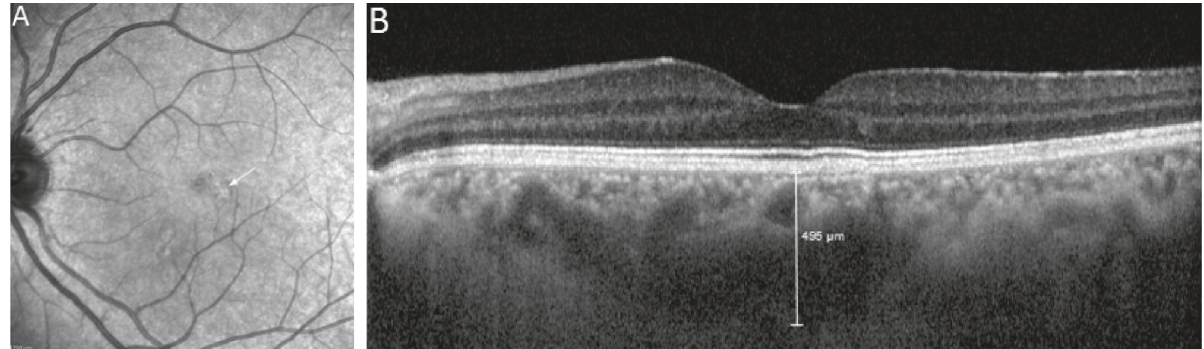
Figure 2: An infrared reflectance image (A) and enhanced depth imaging (EDI) mode of spectral domain optical coherence tomography (SD-OCT) image (B) of a 32-year-old female patient with coeliac disease. Slight hyperreflectivity appears on the infrared reflectance image in the parafoveal region (white arrow). In the SD-OCTimage, pachyveins (enlargement of Haller’s layer) under the retinal pigment epithelium change, and thick choroid (subfoveal choroidal thickness: 495 μ m) is seen.